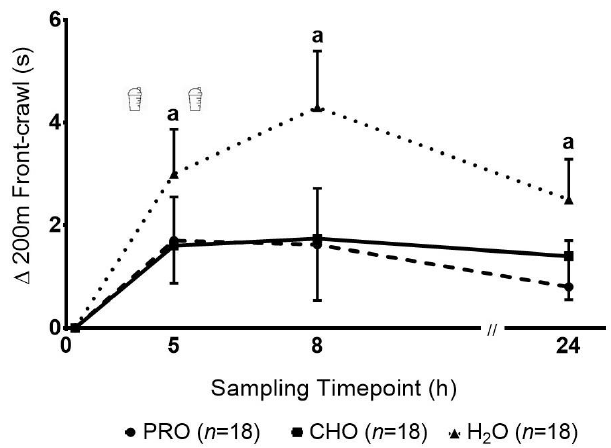
Figure 2. Changes in 200 m front crawl following a high intensity interval swimming protocol in adolescent swimmers. a—indicates a significant decrement ( p < 0.016) in performance (e.g., longer performance times) compared to baseline in all groups.